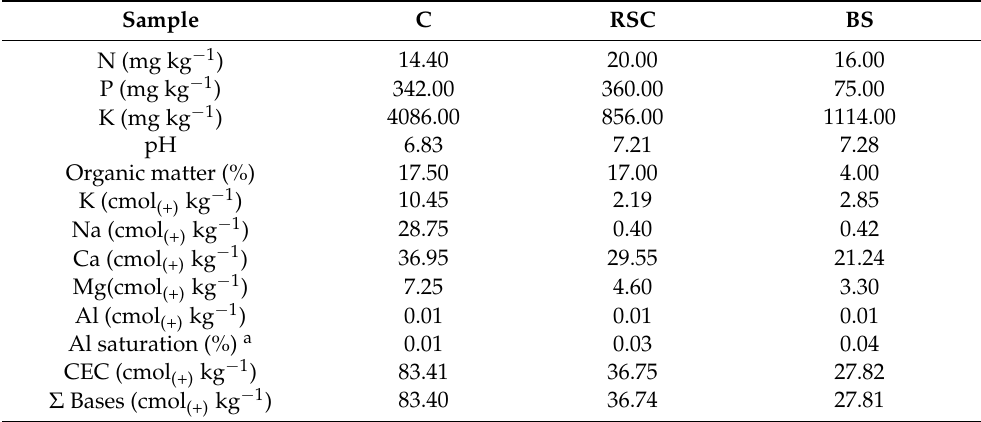
Table 1. Chemical properties of representative composite samples of compost (C), rhizosphere soil with compost application (RSC) and bulk soil